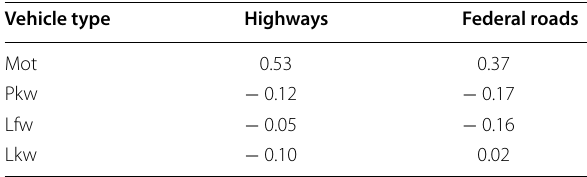
Table 5 Spearman correlation between MSESS values of models with meteorological predictor variables and the population density within a radius of 10 km around the specific traffic stations Vehicle type